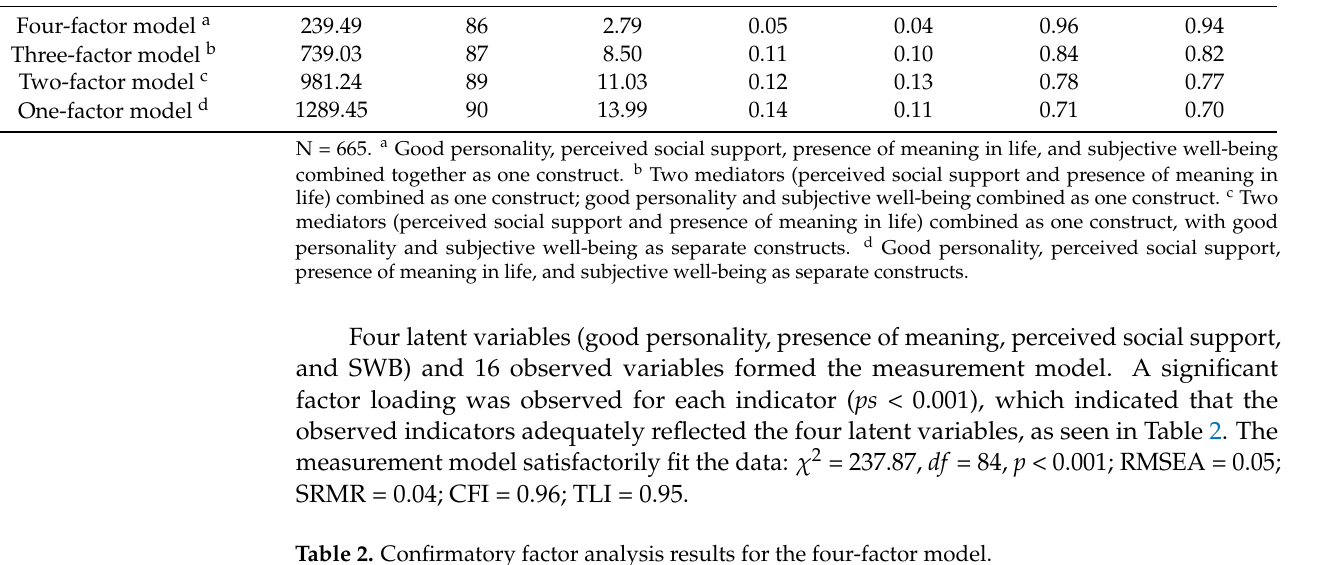
Table 2. Confirmatory factor analysis results for the four-factor